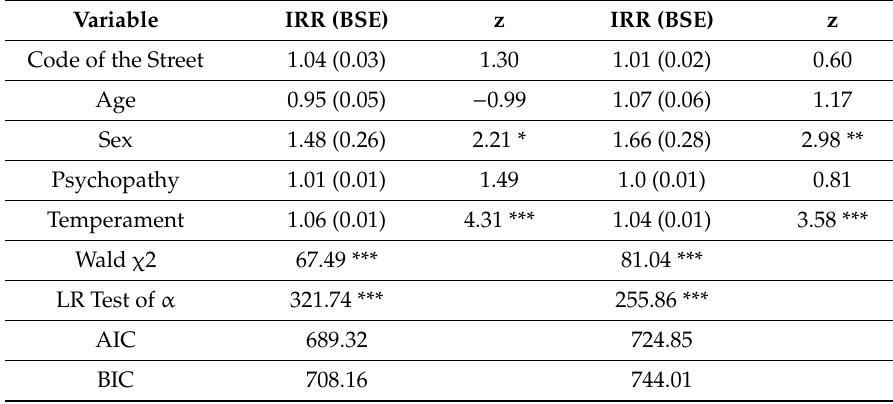
Table 6. Negative binomial regression models for self-reported violence by African American status. Variable IRR (BSE) Code of the